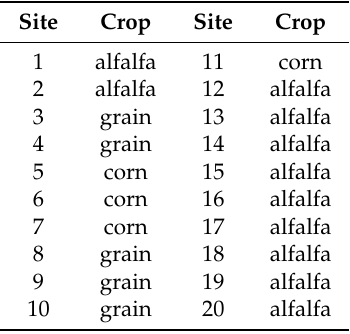
Table 2. Installed crops in soil moisture sampling